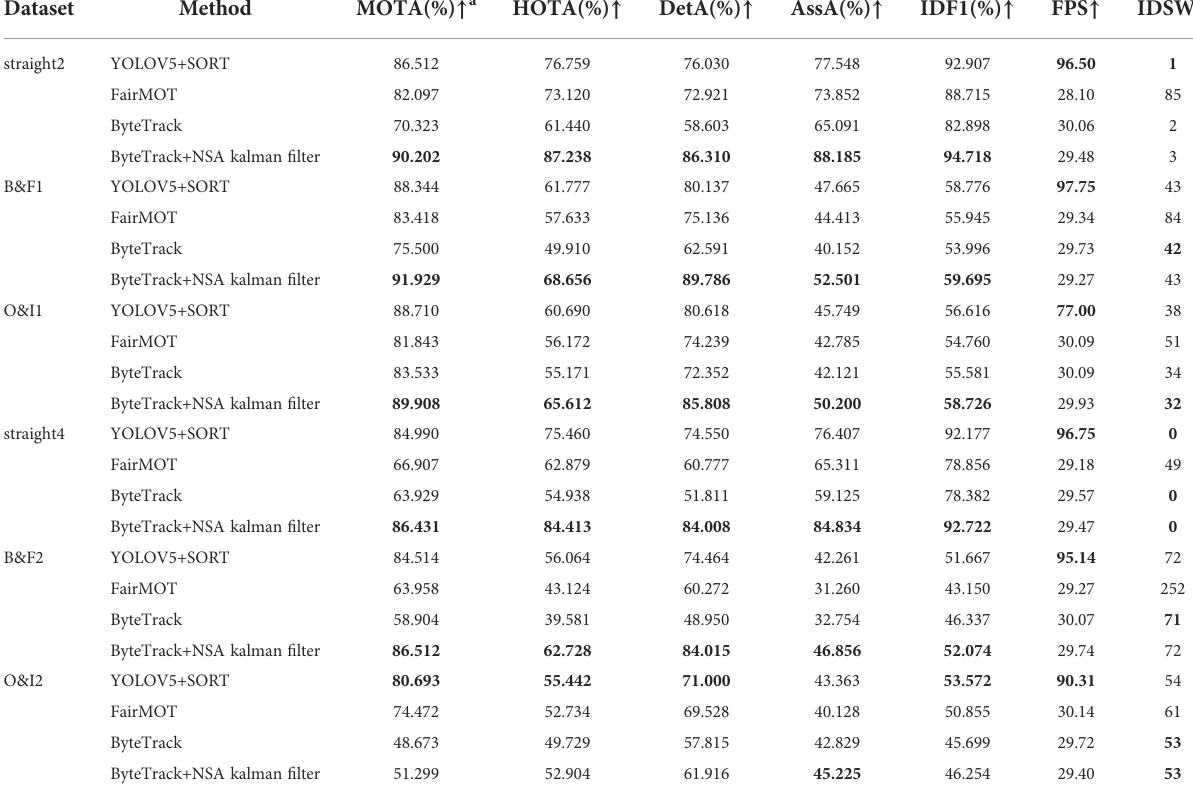
TABLE 3 Performance of four MOT methods with the proposed LettuceMOT.